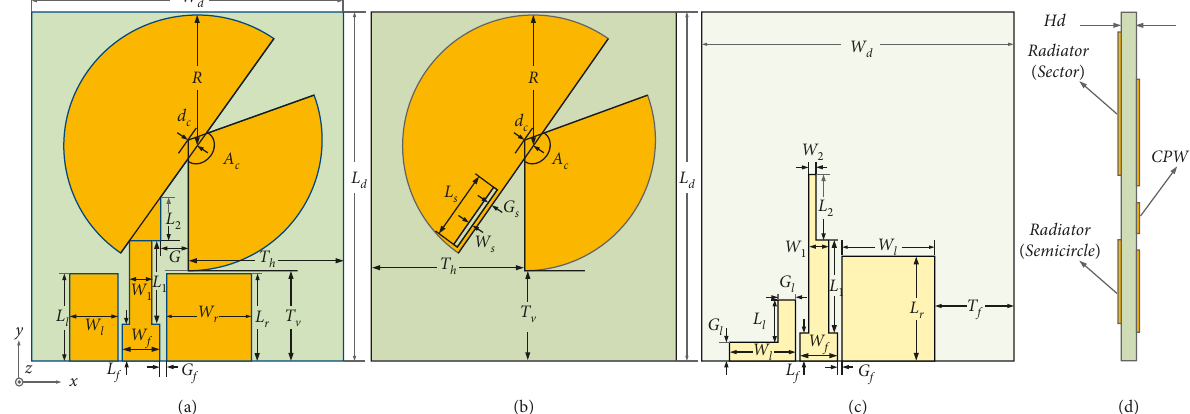
Figure 11: (a) Geometry of An1. (b) Top view of An2. (c) Perspective of An2. (d) Side view of